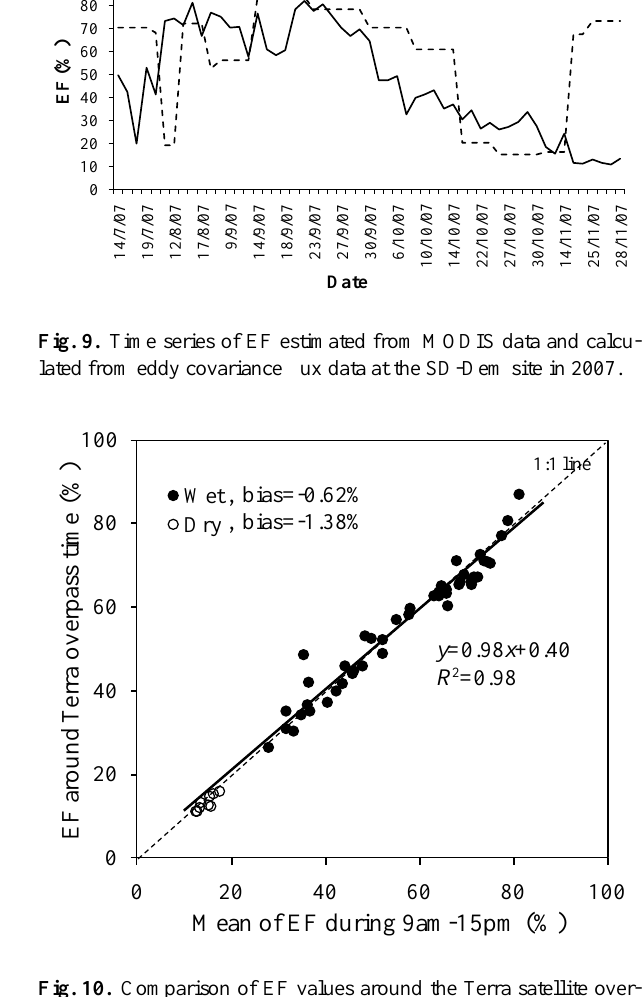
Fig. 10. Comparison of EF values around the Terra satellite over- Fig. 10 . Comparison of EF values around the Terra satellite overpass time and means of pass time and means of EF during 09:00a.m.–15:00p.m. based on EF during 9 am - 15 pm based on ground EC measurements at the SD-Dem site. ground EC measurements at the SD-Dem